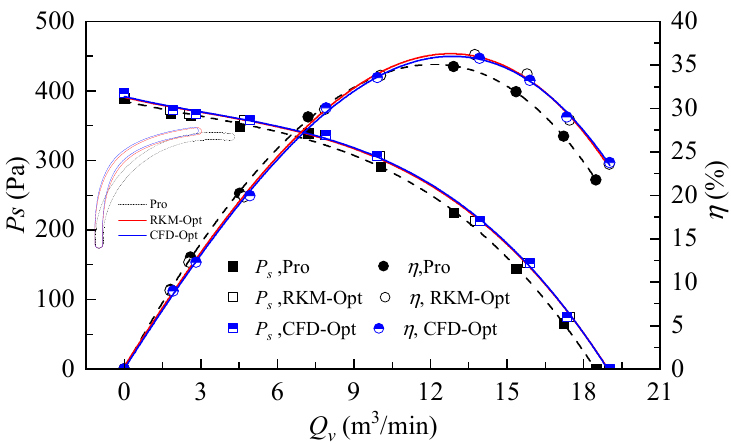
Figure 15. Comparison of the performance curves of the optimal sample of RKM and the CFD with the prototype.